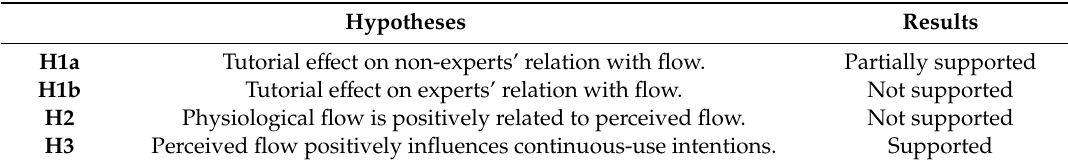
Table 3. Results